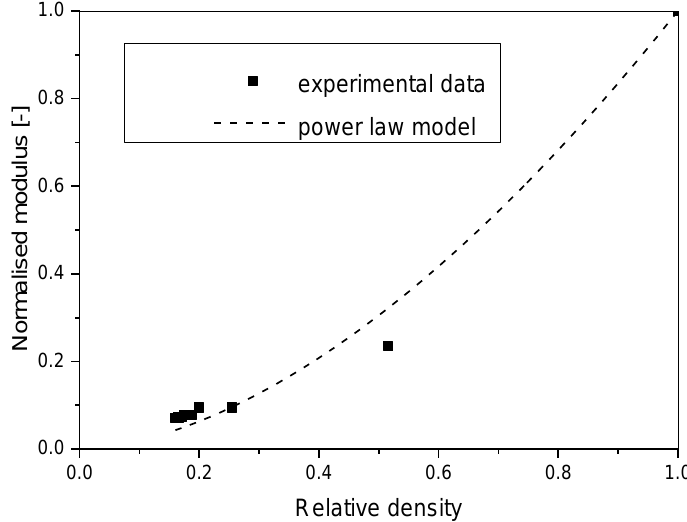
Figure 4. The dependence of the normalised Young’s modulus of pure aluminium foams on relative density. Plotted line is the power law model with R 2 = 0.982, f E = 1.72 ± 0.10.